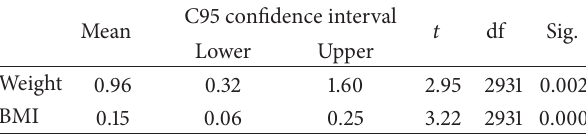
Table 5: Paired sample 𝑡 -test: weight and BMI.